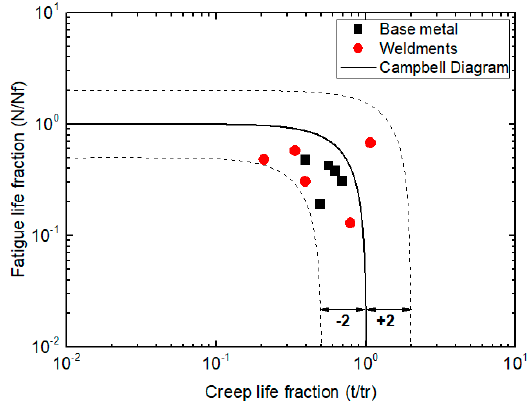
Figure 13. Logarithmic representation of creep-fatigue life interaction based on linear damage summation and its margin line of ±2 scatter band.